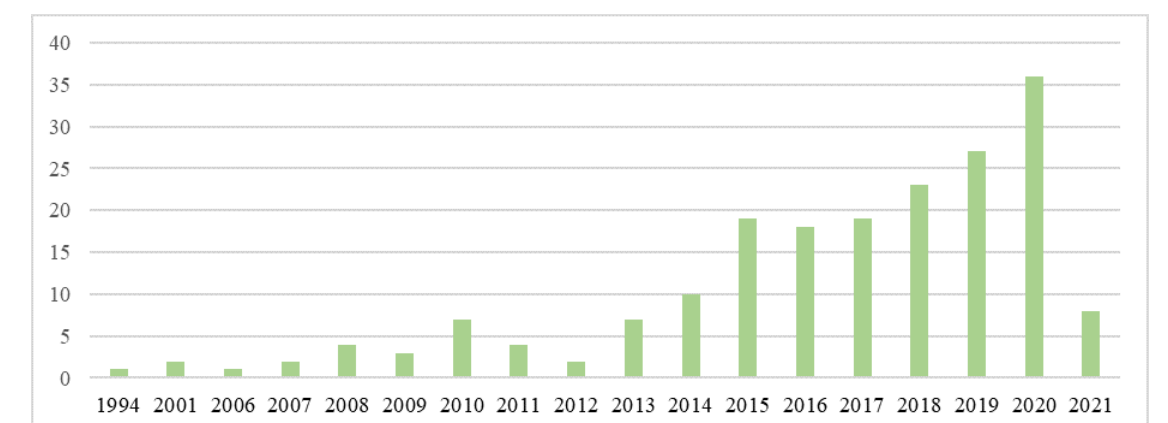
Table 1. Theoretical perspective in prior studies.